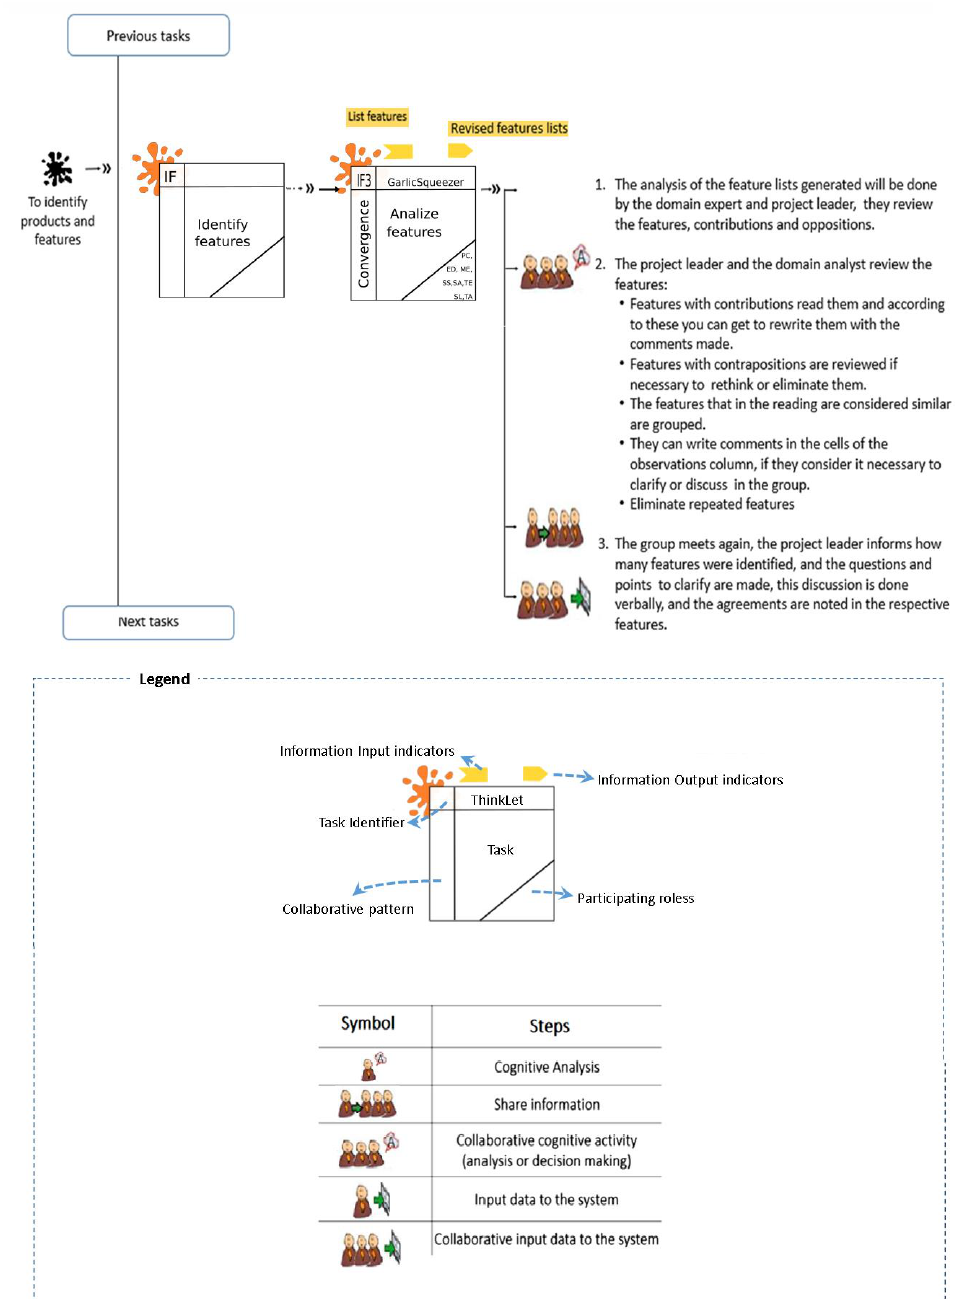
Figure 4. Sub-task analyze